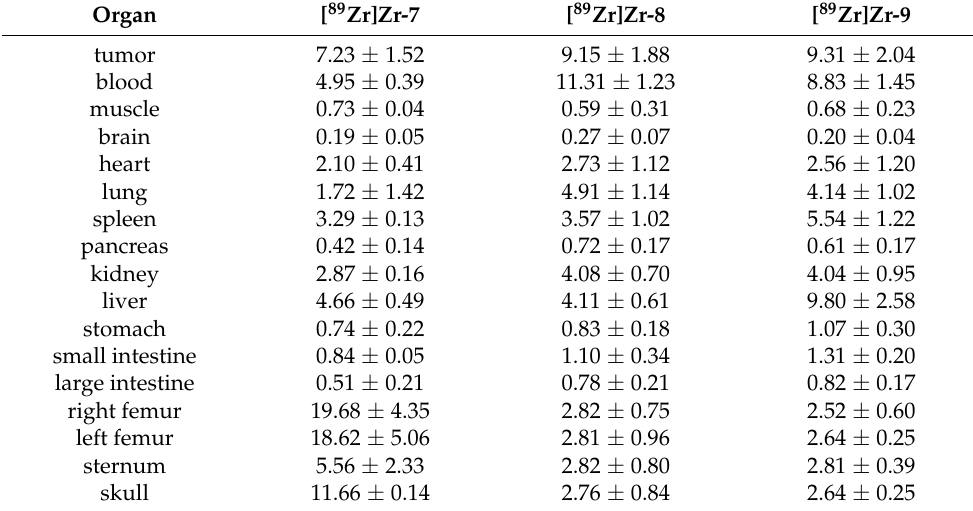
xenograft nude mice, expressed as %ID/g. The values are given as mean ± standard deviation.